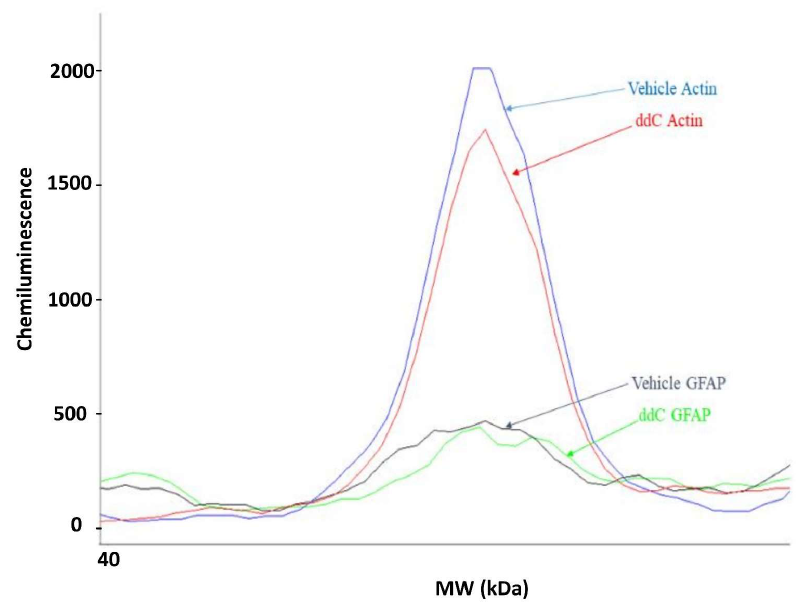
Figure 8. Electropherogram of actin and GFAP expression in brain samples from a control (vehicle- treated) and a ddC-treated